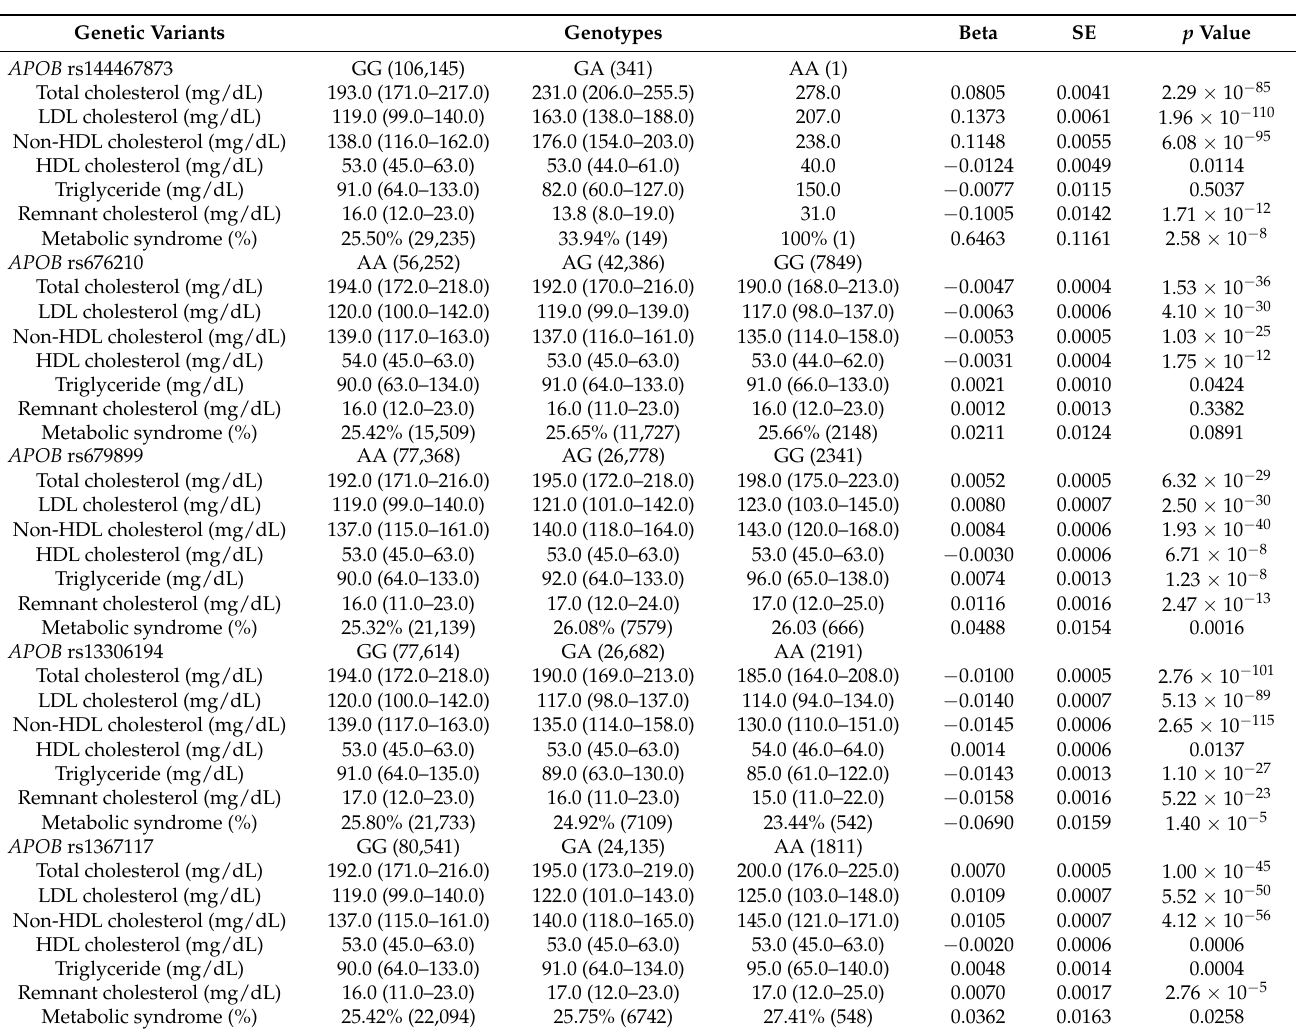
Table 2. Association between APOB nonsynonymous mutations and serum lipid profiles and metabolic